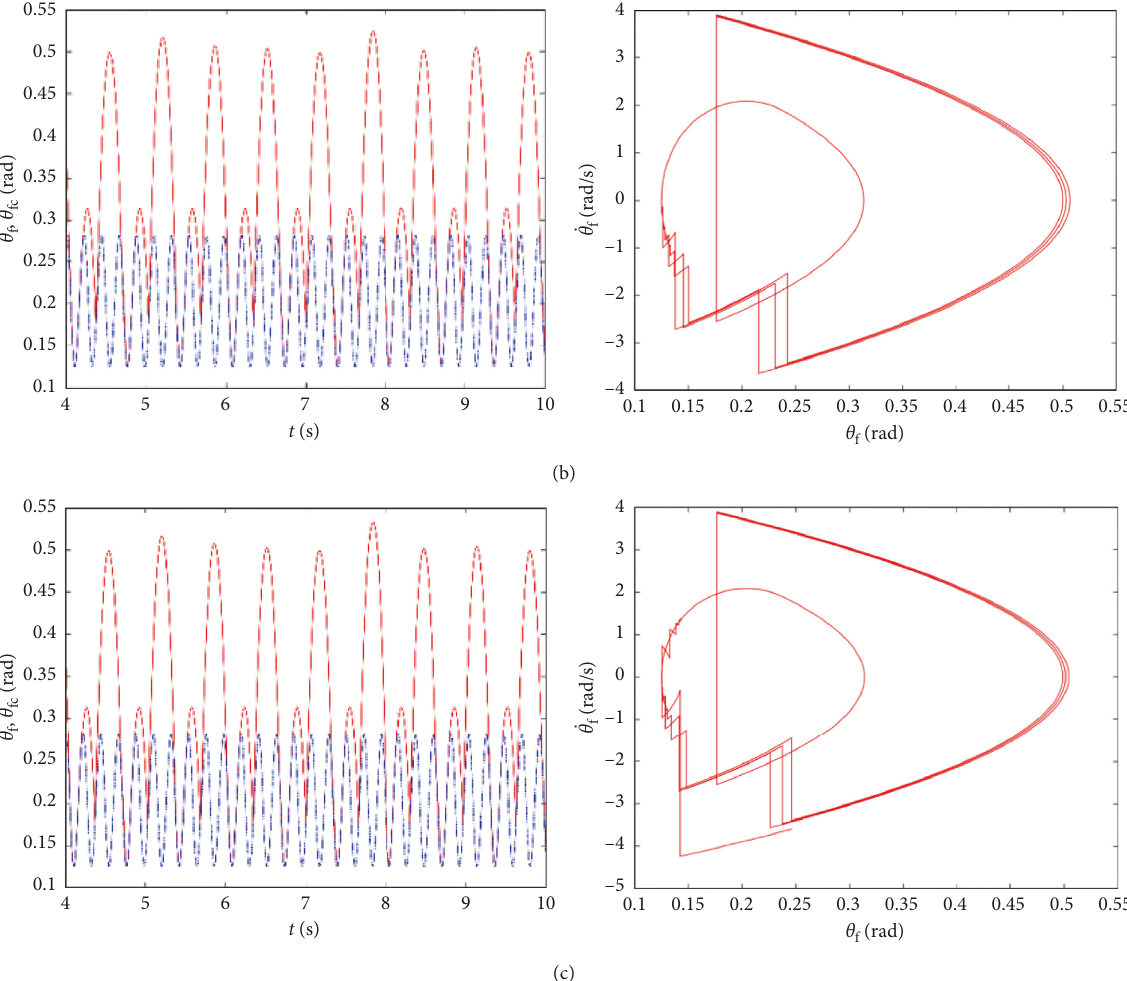
Figure 8: System response for the different σ ( μ � 0 . 015 m). (a) Quasiperiod 2 ( σ � 0 . 001m; left frame: red represents θ θ ). (b) Quasiperiod 2 ( σ � 0 . 002 m; left frame: red represents θ fc , blue represents θ ). represents θ f fc